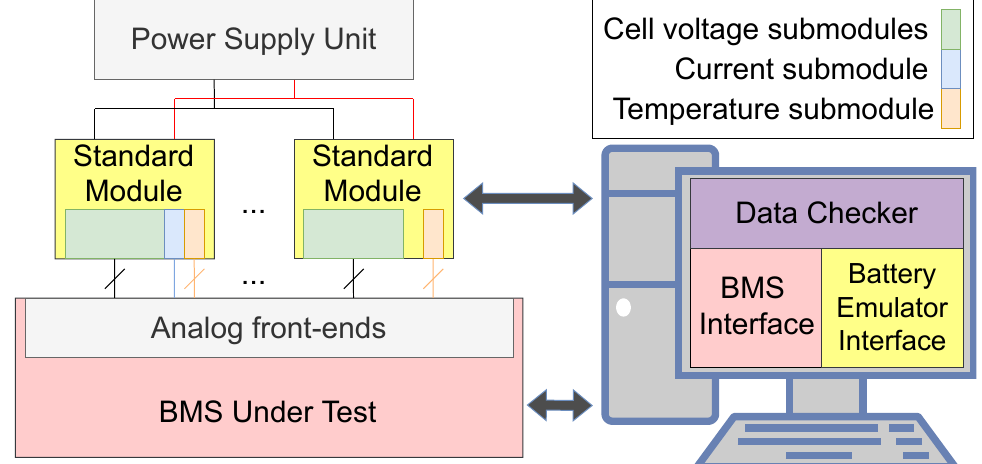
Figure 1. Block scheme of the testing environment of the proposed battery emulator. Each standard module emulates up to eight series-connected cells and is based on a rack structure composed of an interconnection board which can be equipped with up to eight cell voltage submodules, one temperature submodule with eight channels, one current submodule, and a control board. The interconnection board is provided with an edge card connector for each submodule and external connectors for the submodule outputs, the power supply, and the external communications. Moreover, vertical supports prevent the insertion of a submodule in the wrong connector and provide the possibility to mount two 80 mm cooling fans. The rack structure allows the battery emulator upgrade by adding or replacing submodules without changing the entire platform. The general block diagram of the standard module and its 3D rendering are shown in Figure 2.